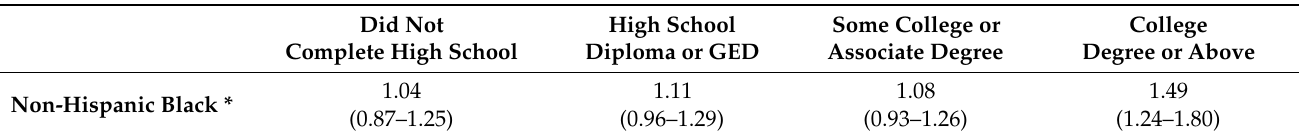
Table 3. Association between race and Allostatic Load by education level in Non-Hispanic Black and Non-Hispanic White men in the 1999–2016 NHANES